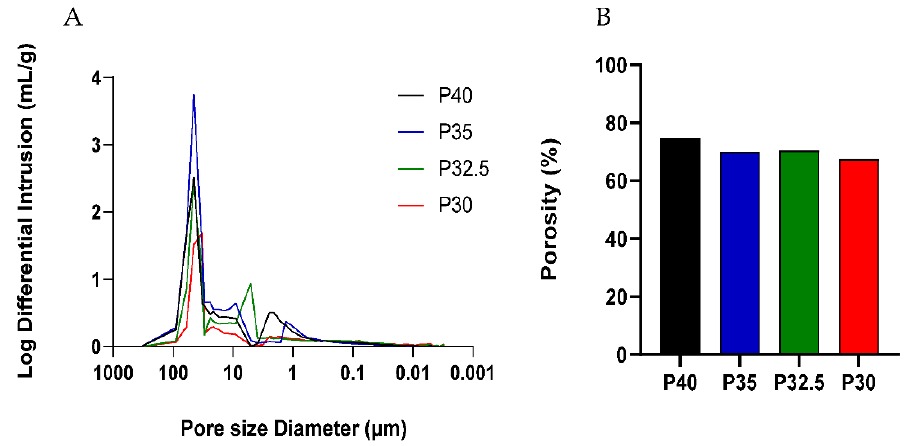
Figure 2. ( A ) Log differential intrusion curves of porous PBG microspheres highlighting the range of pore sizes achieved, and ( B ) Porosity (%) of microspheres obtained from the four PBG formulations.